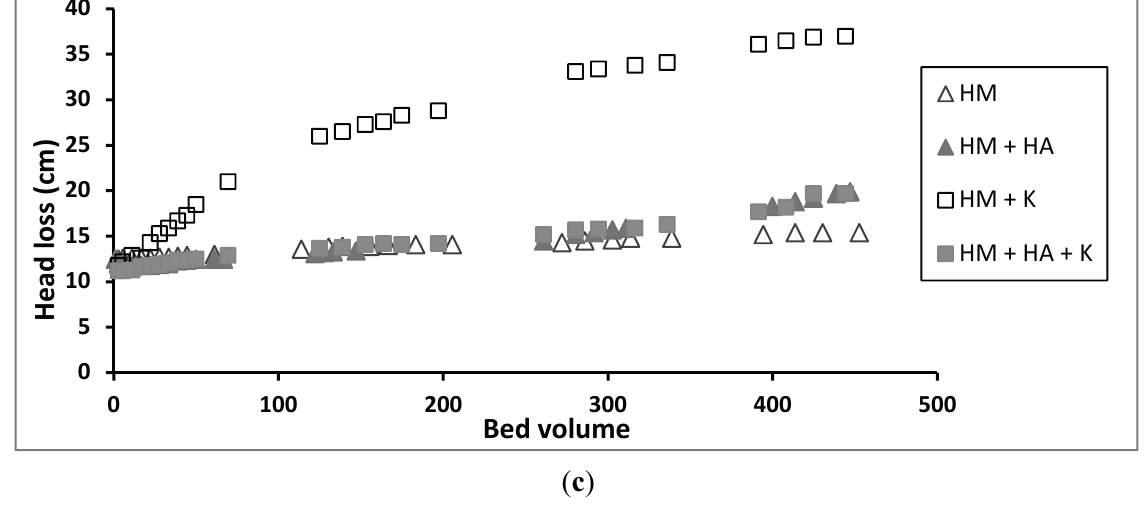
Figure 5. ( a ) DOC, ( b ) turbidity removals and ( c ) head loss generation in the column study (HM—heavy metals, K—kaolinite,